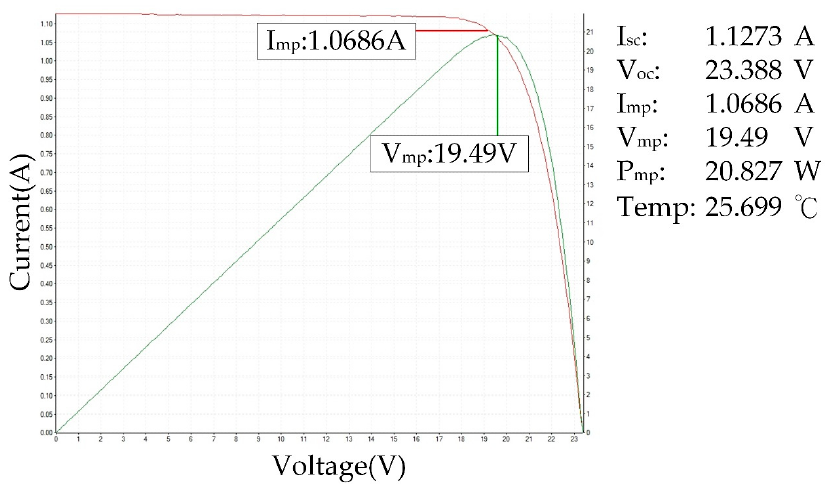
Figure 4. PV module I-V curve.